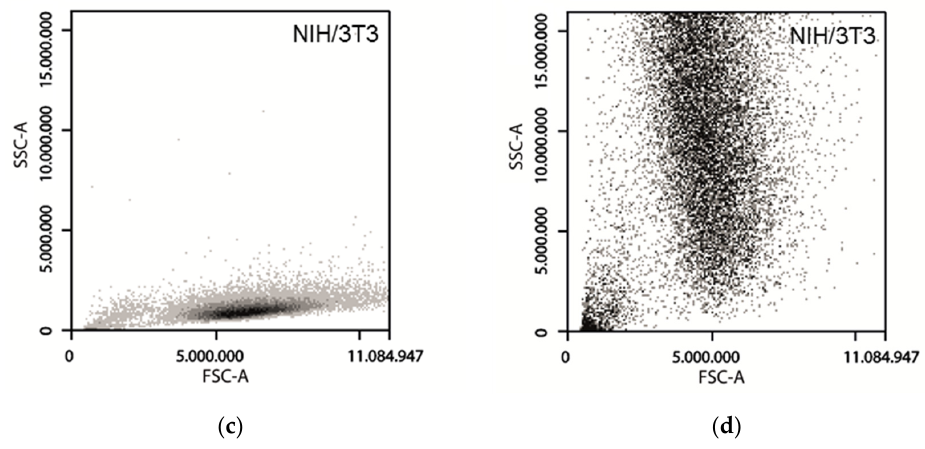
Figure 2. Density Plots of SSC and FSC signals of A549 and NIH/3T3 cells. Cells were incubated with each sample for 24 h. ( a ) A549 cells with 0 μ g mL − 1 FITC ‐ TiO 2 ; ( b ) A549 cells with 25 μ g mL − 1 FITC ‐ TiO 2 ; ( c ) NIH/3T3 cells with 0 μ g mL − 1 FITC ‐ TiO 2 ; ( d ) NIH/3T3 cells with 25 μ g mL − 1 FITC ‐ TiO 2 .